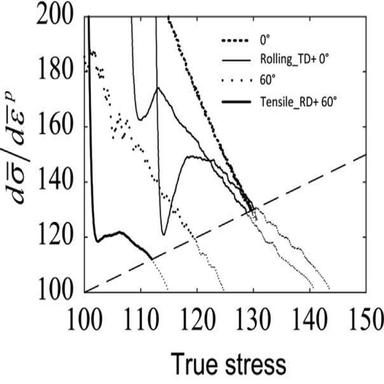
Kocks-Mecking plots for tension in the 60° direction with and without 8% prestrain in tension along the RD and for tension along the RD with and without 12% and 15% prestrain by rolling in the TD.